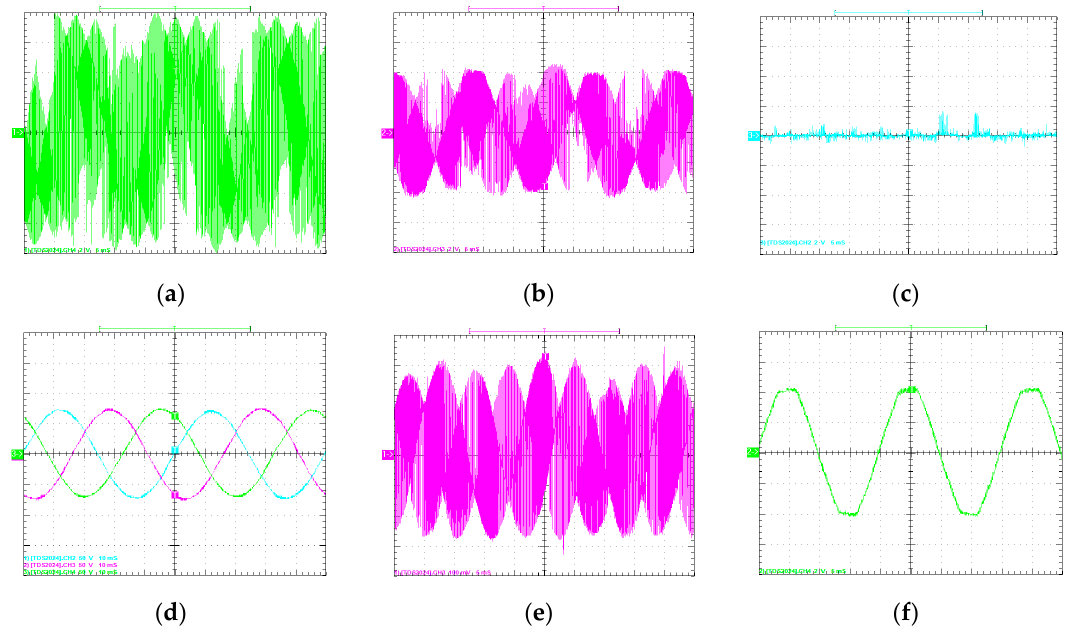
Figure 11. Waveforms registered in three-to-three-phase MC: output line-line voltage ( a ); output phase voltage ( b ); CMV ( c ); output currents ( d ); input current ( e ); input phase voltage ( f ).